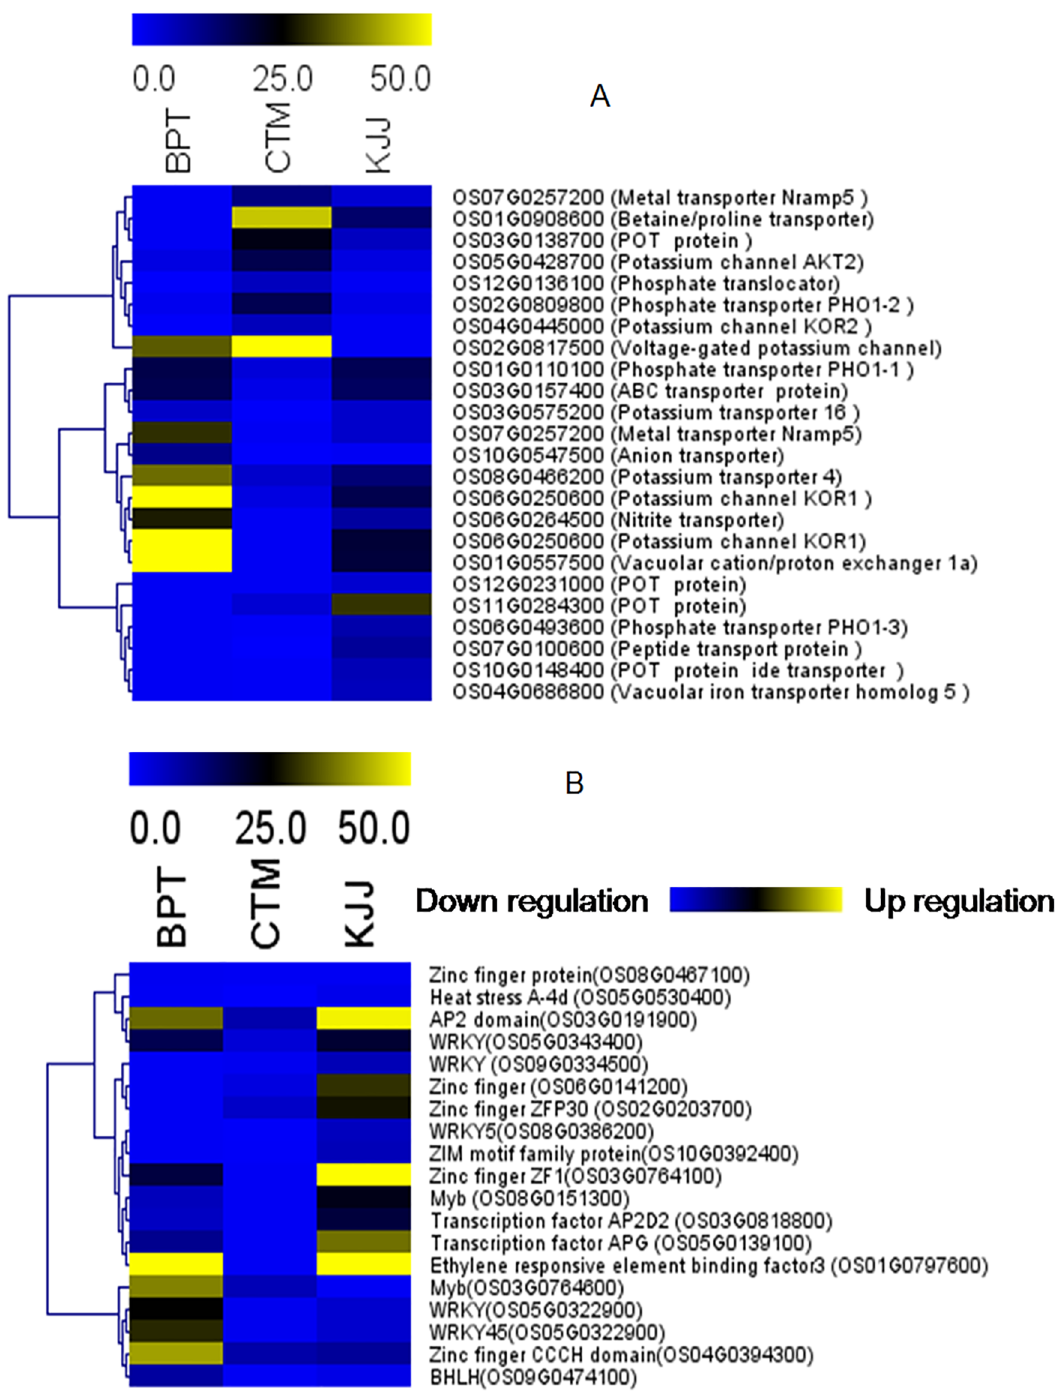
Fig 3. Representation of differentially expressed transcripts. Differentially expressed transporters in BPT 5204, CTM and KJJ (A) Differentially expressed transcription factors in BPT 5204, CTM and KJJ (B).